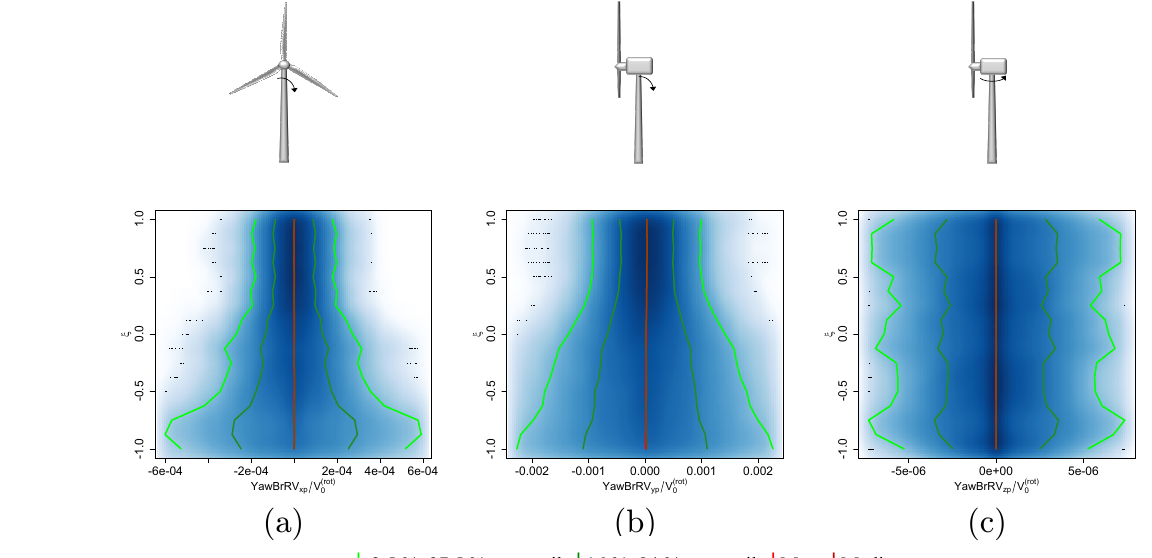
Figure 6. Variation with ξ of the PDFs of the tower top’s angular velocities. (a) In the plane of the rotor. (b) Across the plane of the rotor. (c) Torsional. The parameter ξ is represented by the vertical axis, starting with an entirely positive shear at the bottom (where ξ = − 1) and ending with an entirely negative shear at the top (where ξ = 1). The horizontal axis represents values of the tower top’s angular velocities (YawBrRV) normalized by a reference ( V (rot) ). The background color is deeper where values are more concentrated. The red line and the 0 dark red line connect the mean and the median values, respectively. The green lines and the dark green lines delimit the zones encompassing 95 and 68% of the values, respectively.